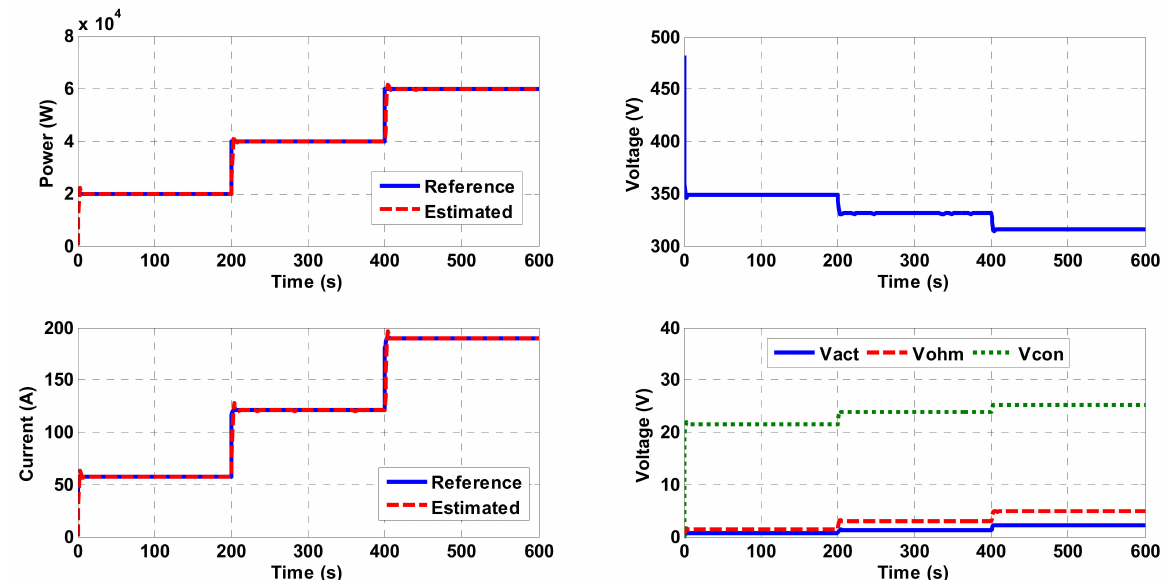
Figure 11. Second load disturbance applied on SOFC stack dynamic